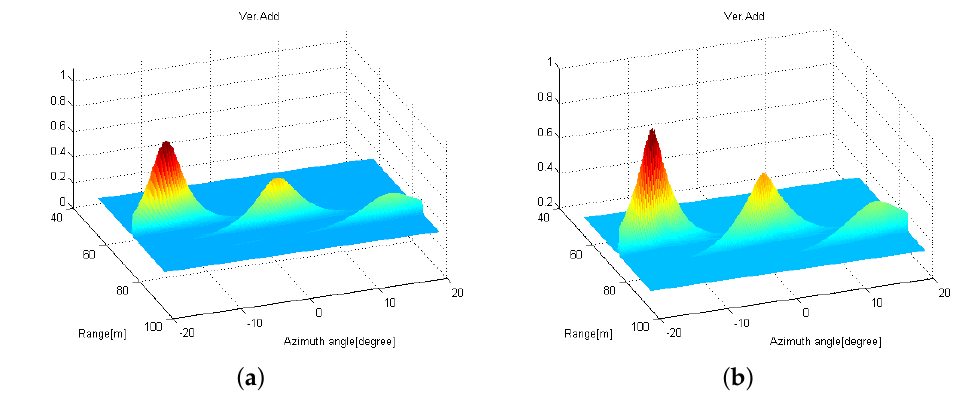
Figure 7. Radar images obtained by using the proposed distributed 2D MUSIC algorithm with ( a ) D = 5 m and ( b ) D = 10 m.